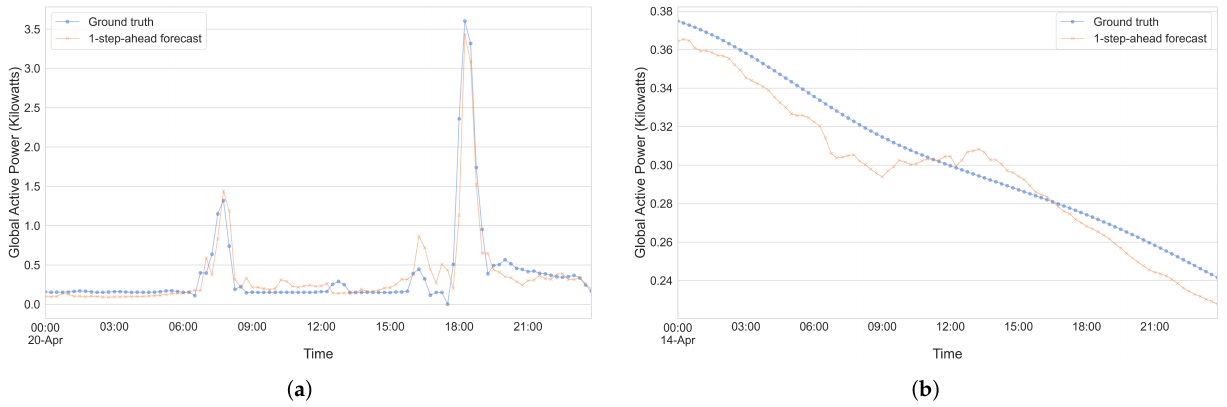
Figure 21. Showcasing the ability of our method to make one-step-ahead predictions on the REFIT dataset. ( a ) REFIT—Raw data. ( b )